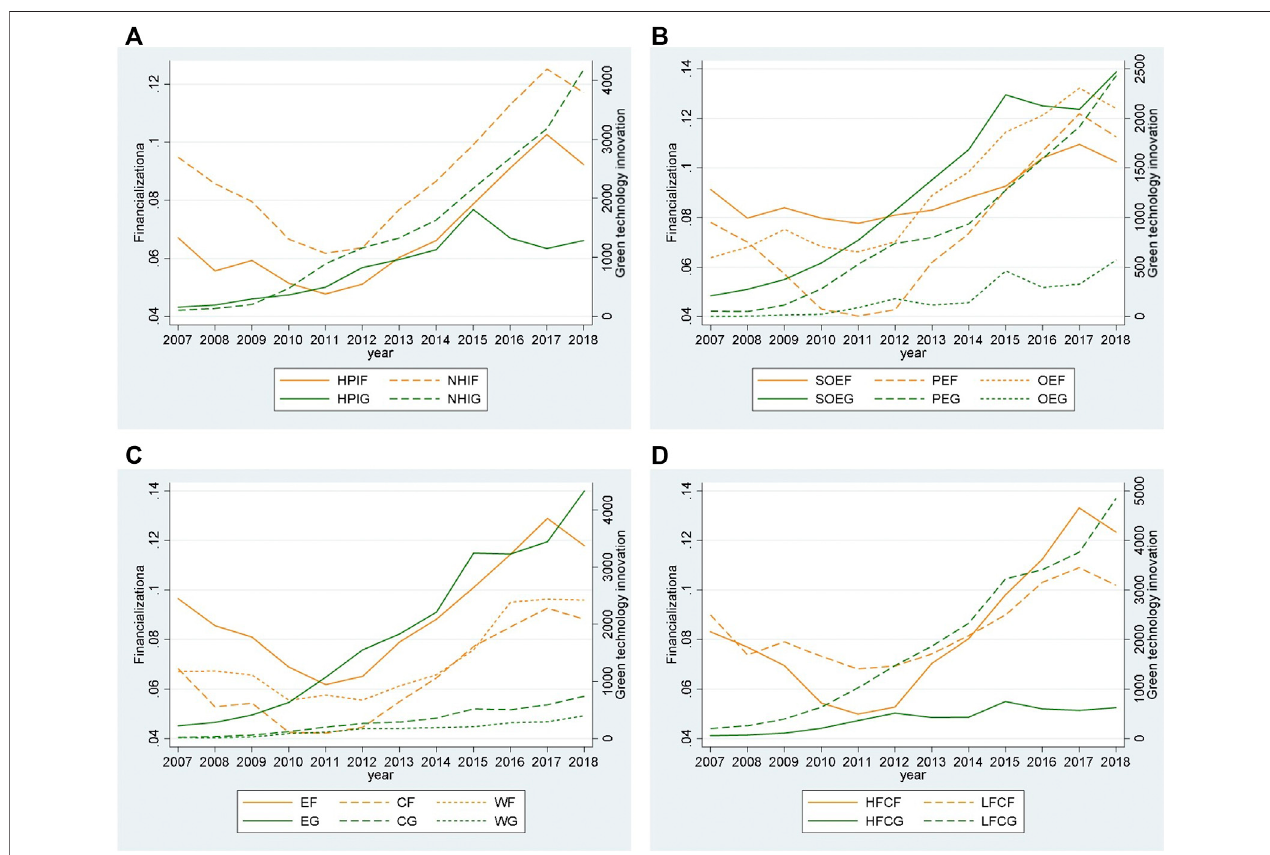
FIGURE 1 | Line charts of the annual mean of fi nancialization degree and the sum of green technology innovation quantity in each year: (A) the line chart of enterprises in industries with different pollution degrees. HPIF and NHIF represent annual means of fi nancialization degree of enterprises in the heavy pollution industry andthenon-heavypollutionindustryrespectively;HPIGandNHIGrepresentannualtotalofgreeninnovationquantityofenterprisesintheheavypollutionindustryandthe non-heavypollutionindustryrespectively; (B) thelinechartofenterprisesunderdifferentownership.SOEF,PEFandOEFrespectivelyrepresenttheannualaverage of the fi nancialization degree of state-owned enterprises, private enterprises and other enterprises; SOEG, PEG and OEG respectively represent the sum of the green innovationquantityofstate-ownedenterprises,privateenterprisesand otherenterprises ineach year; (C) thelinechartofenterprisesindifferentregions. EF,CFandWF respectively represent the annual average of the fi nancialization degree of enterprises in the east, central and west of China, and EG, CG and WG respectively represent the sum ofthe number ofgreen innovation ofenterprisesin theeast, central and west ofChina. (D) the linechart ofenterpriseswith different fi nancing constraints. HFRF and LFRF respectively represent the annual average of fi nancialization degree of enterprises with high fi nancing constraints and low fi nancing constraints, while HFRG and LFRG respectively represent the sum of green innovation quantity of enterprises with high fi nancing constraints and low fi nancing constraints in each year.